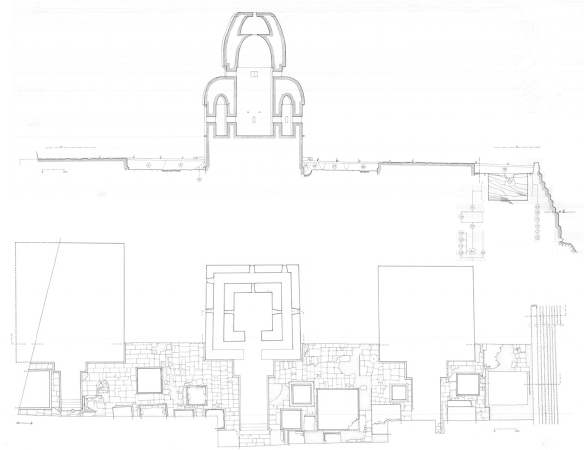
Figure 6 . Gumbat: The archaeological area of GBK I. Cross- section and plan (after the end of the excavations; 2011).